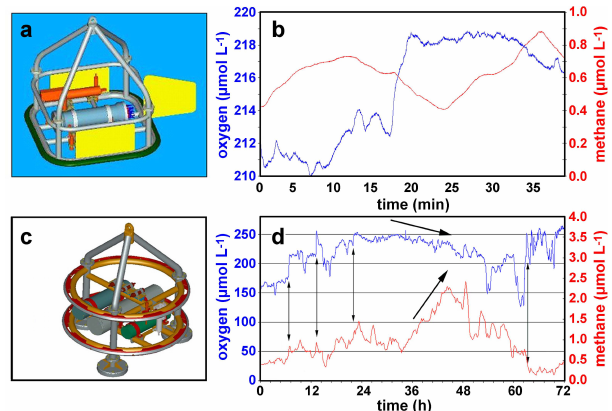
Fig. 11. Left-hand panels: MEDUSA system ( a ) and GMM ben- thic observatory ( c ) used for spatial surveying and temporal moni- toring, respectively, in Katakolo Bay. Right-hand panels: illustrative records showing the inverse relationship between O 2 and CH 4 : oxy- gen depletion related to an increase in the concentration of methane over a submarine bubble seep as recorded by the MEDUSA towing system ( b ) and short-term and long-term changes in oxygen con- centration accompanied by inverse changes in methane concentra- tion recorded over a period of three days in a submarine seep by the GMM ( d ).